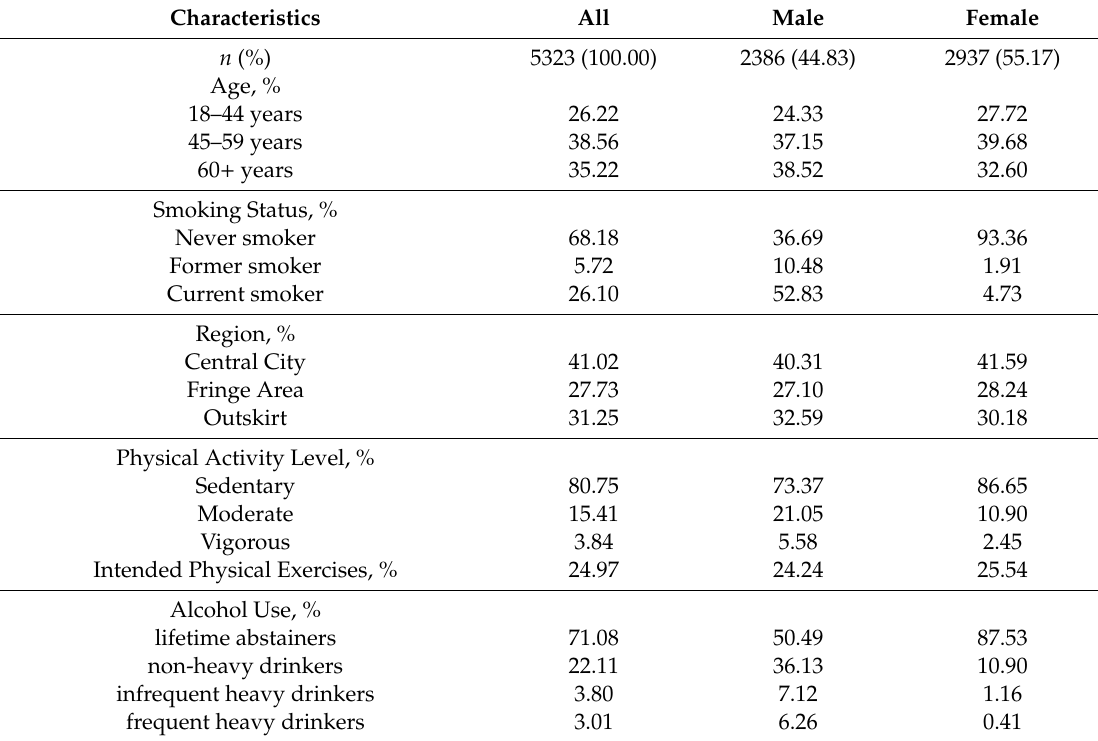
Table 1. Characteristics of the participants in the study